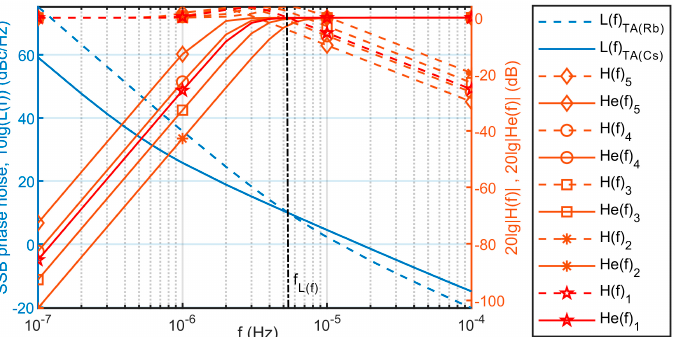
Figure 10. Comparison chart of frequency domain intersection points under different parameter pair selection values.